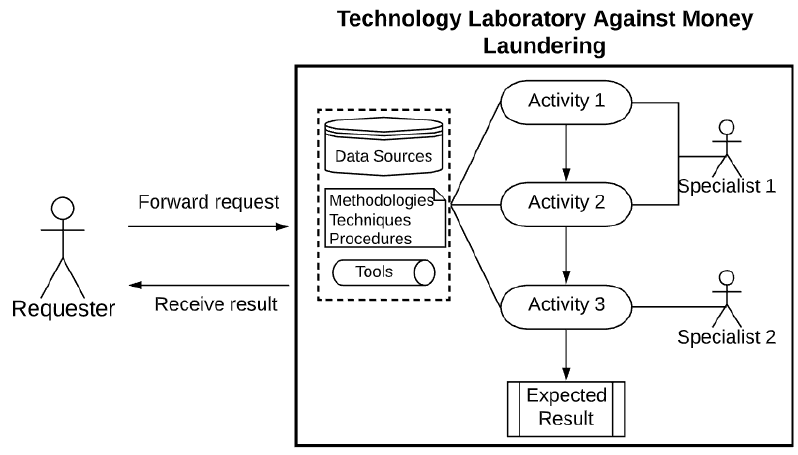
Figure 2. Example of request flow to a technology laboratory against money laundering.